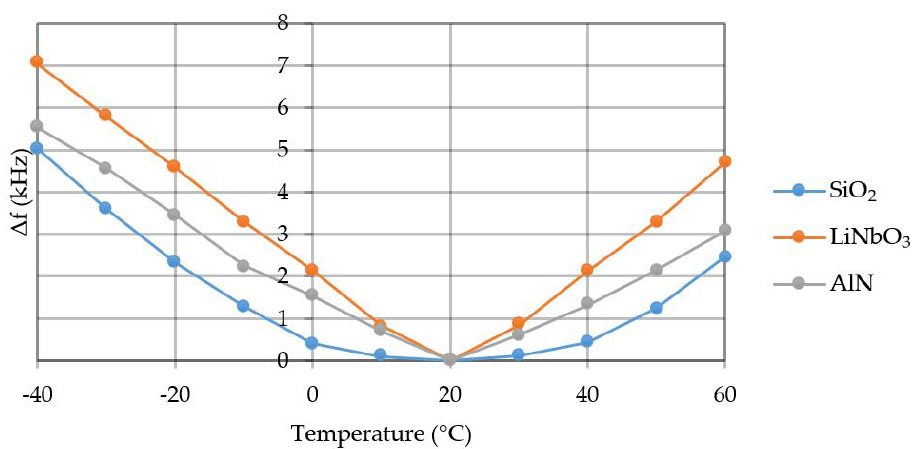
Figure 13. Graph of the frequency change under temperature.